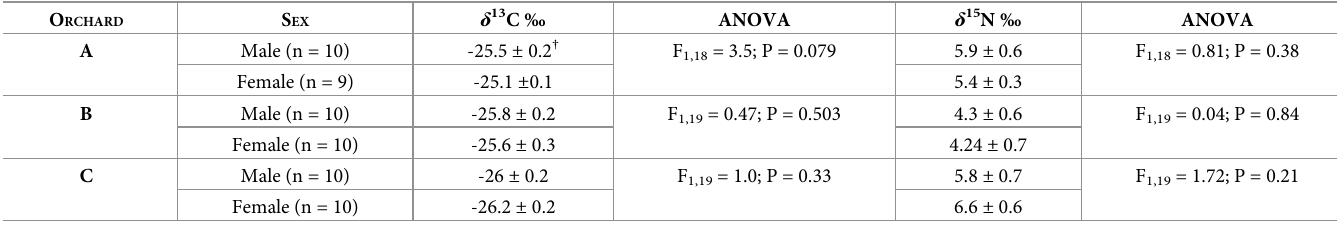
Table 1. Isotopic composition of males and females (means ± SE) of wild Anastrepha fraterculus flies from three apple orchards.